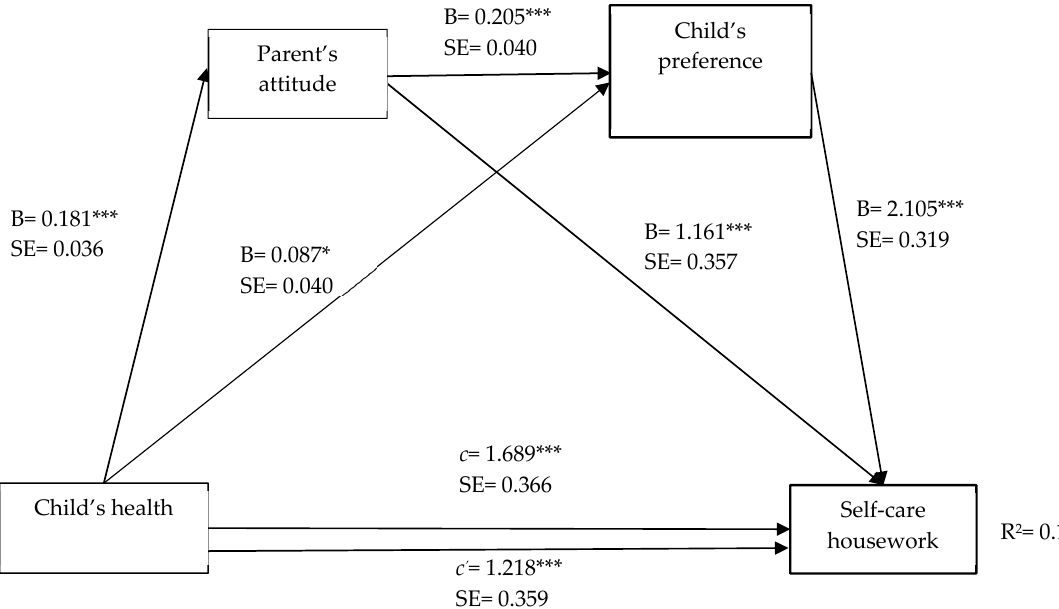
Figure 1. Serial multiple mediation of parents’ attitude and child’s housework preference in the relationship between child’s health and self-care housework, with non-standardized beta values. *** p < 0.001, * p < 0.05. Table 3. Serial mediation effects on the relationship between Child’s health and Self-care Chores.